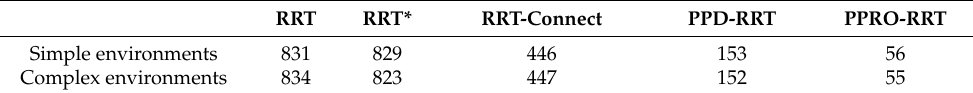
Table 2 indicates the number of random tree points obtained by various path planning algorithms. For each of the algorithms, the number of random tree points hardly varied with the complexity of the environment. Compared with the RRT algorithm, the number of random tree points of the PPD-RRT algorithm was reduced by approximately 81.59% and 81.76% in two kinds of experimental environments, and after adding the RO idea, the number of points was reduced by about 93.25% and 93.32%. Compared to the RRT* and RRT-Connect algorithms, the number of random tree points of the PPRO-RRT algorithm